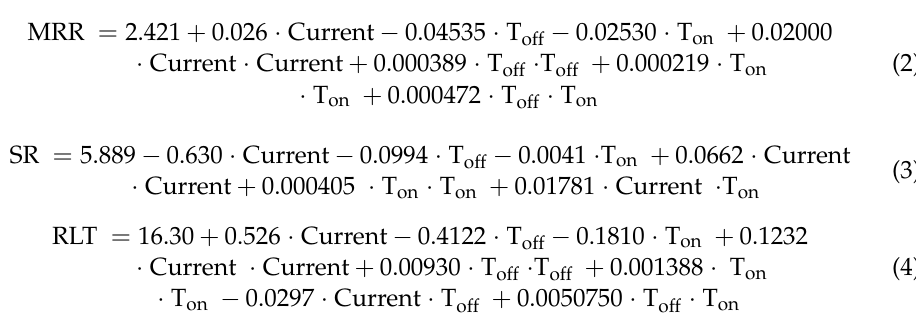
Figure 3. MWCNT analysis: ( a ) SEM of MWCNT nano-powder ( b ) Raman profile ( c ) XRD spectra of MWCNT [62].